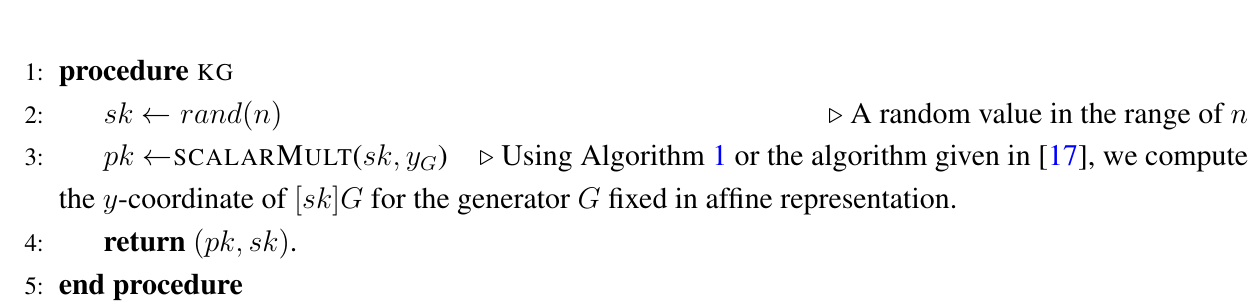
Algorithm 4 Key generation.